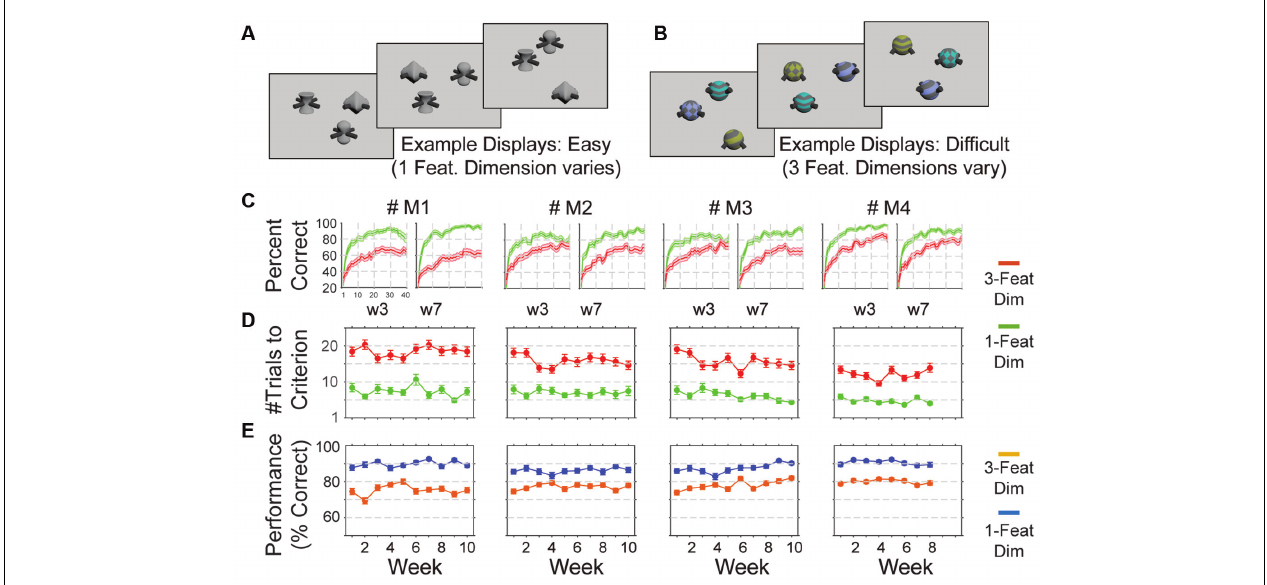
FIGURE 4 | Measuring cognitive flexibility. (A,B) Example displays with three multidimensional objects for the feature-reward learning task. The task required the monkey to learn which feature is linked to reward in blocks of 45–55 trials. The target object that was rewarded was defined by a specific feature. Objects varied trial by trial either in features of one dimension (e.g., only body shapes in A ) or of two or three dimensions (e.g., pattern, color, and arm types in B ). (C) Performance learning curves averaged over five sessions in weeks 3 and 7 (w3, w7) for monkeys one to four ( left to right ). Green and red lines correspond to the easy and difficult conditions (varying 1 or 2/3 feature dimensions. (D) For four monkeys (columns) the average number of trials needed to reach learning criterion in the easy and difficult conditions over 15 weeks (five sessions per week). (E) Same format as (D) for the plateau performance of monkeys in trials after the learning criterion was reached. Error bars or shading correspond to